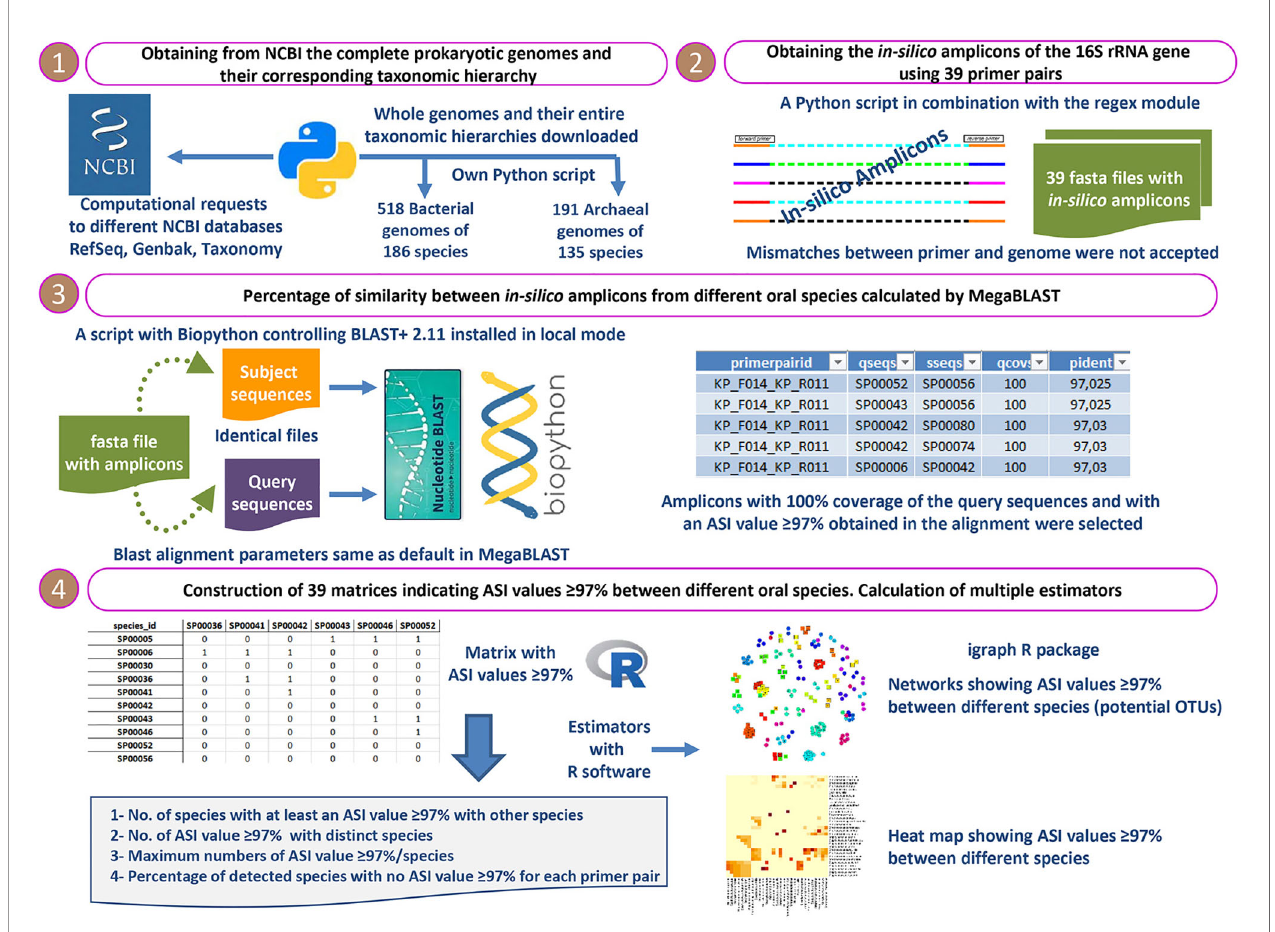
FIGURE 1 | The complete analysis protocol applied in the present in-silico